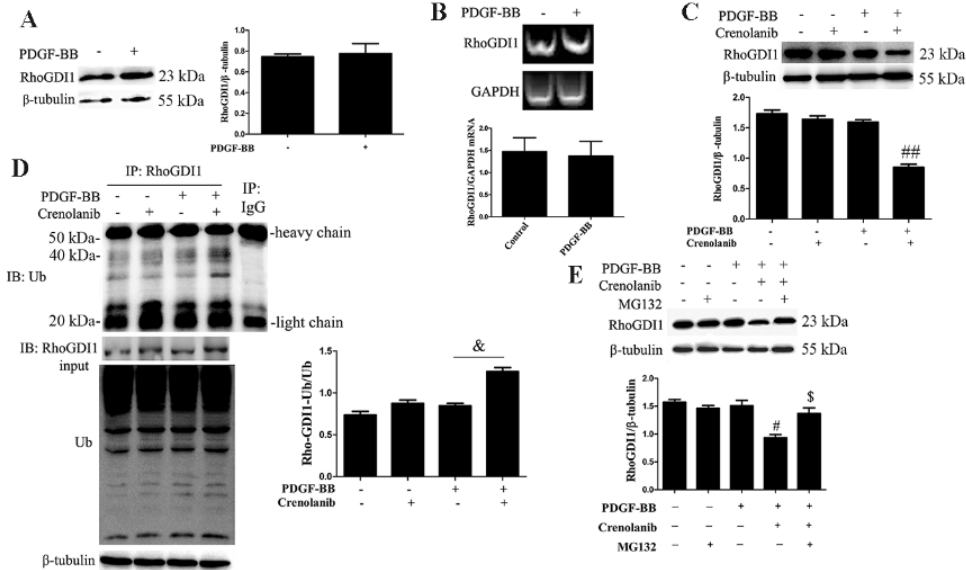
Figure 1. PDGF-BB stabilizes RhoGDI1 protein via the PDGF receptor. HA-VSMCs were pretreated with crenolanib (50 nM) for 48 h or MG132 (5 µ M) for 1 h and then followed by 10 ng/mL PDGF-BB treatment for 24 h. Untreated cells were used as control. ( A ) Western blot analysis showed that PDGF-BB treatment did not affect RhoGDI1 protein level. Histogram showing the ratio of RhoGDI1 to β -tubulin ( n = 3). ( B ) Real-time RT-PCR analysis also showed that PDGF-BB did not affect RhoGDI1 mRNA level. Histogram showing the ratio of RhoGDI1 mRNA level to GAPDH mRNA level ( n = 3). ( C ) Western blot showed that crenolanib reduced RhoGDI1 protein level in PDGF-BB-treated HA-VSMCs. Histogram showing the ratio of RhoGDI1 to β -tubulin. ##, p < 0.01 vs. the PDGF-BB-treated group ( n = 3). ( D ) Co-IP analysis of RhoGDI1 polyubiquitination. RhoGDI1 was immunoprecipitated from the cell lysates using the specific antibodies, and then the immunoprecipitated proteins were analyzed by western blotting. IgG immunoprecipitation was used as a negative control, showing heavy chain and light chain. Crenolanib treatment promoted RhoGDI1 polyubiquitination in PDGF-BB-induced cells. Histogram showing the ratio of RhoGDI1-binding ubiquitin to total ubiquitin. &, p < 0.05 vs. the PDGF-BB-treated group ( n = 3). ( E ) Western blot showed that MG132 reversed the decreased RhoGDI1 protein level caused by crenolanib. Histogram showing the ratio of RhoGDI1 to β -tubulin. #, p < 0.05 vs. the PDGF-BB-treated group; $, p < 0.05 vs. the PDGF-BB and crenolanib-treated group ( n =